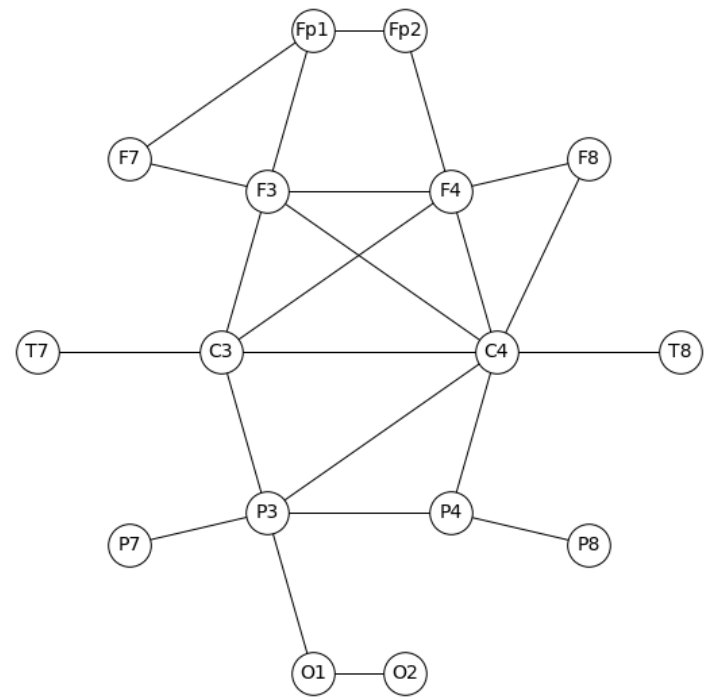
Figure 3. Coherence graph representation—coordination epoch (an exemplar players). Graph layout is in accordance with electrode placement on the scalp.